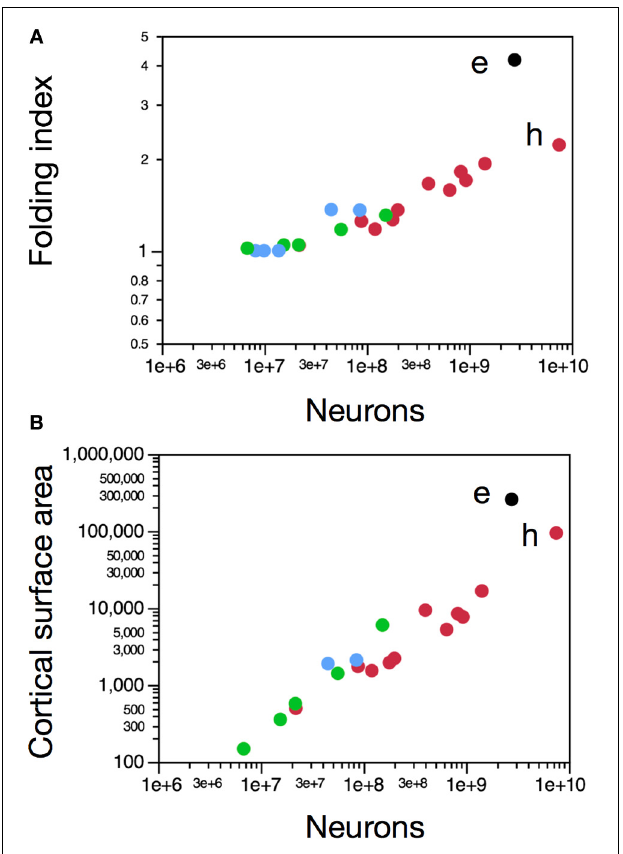
FIGURE 2 | Neurons in the elephant cerebral cortex are more spread out laterally, resulting in a more highly folded cortex than in other species with more cortical neurons. Each data point represents values for one cerebral hemisphere in one species. Graphs show variation in folding index (A) and total surface area of the cerebral cortex (B) as a function of the number of neurons in the cerebral cortex in the elephant (black, e) and other species [other afrotherian species in blue, primates in red (human, h), and glires in green]. Data from Neves et al. (2014) and Ventura-Antunes et al.